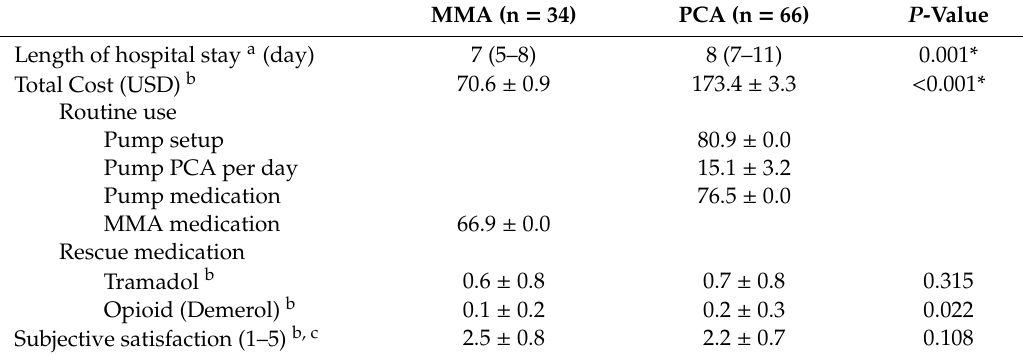
Table 5. Length of hospital stay, cost for pain control, and subjective satisfaction